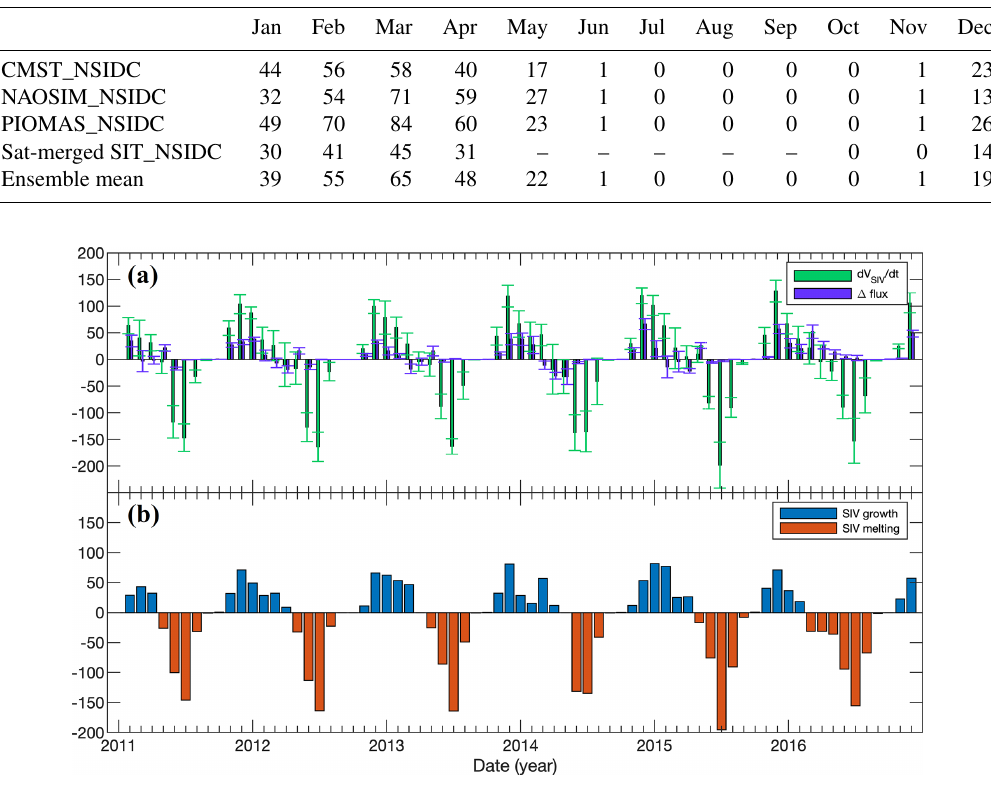
Figure 5. The ensemble mean sea-ice volume changes from net ice flux and thermodynamics growth. (a) The ensemble mean SIV variability (d V SIV / d t , green bar) in the defined Baffin Bay area and the net SIV flux ( (cid:49) flux, purple bar) together with the ensemble spread (error bar). (b) The SIV variability derived from ice freezing (blue bar) and melting (orange bar) in the defined